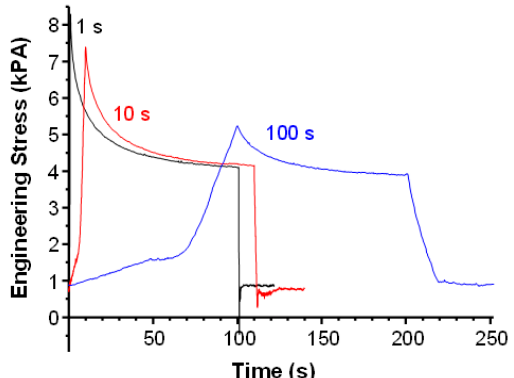
Figure 4. Mechanical compression engineering stress records for MPBA- co -AAm hydrogels in 9 mM